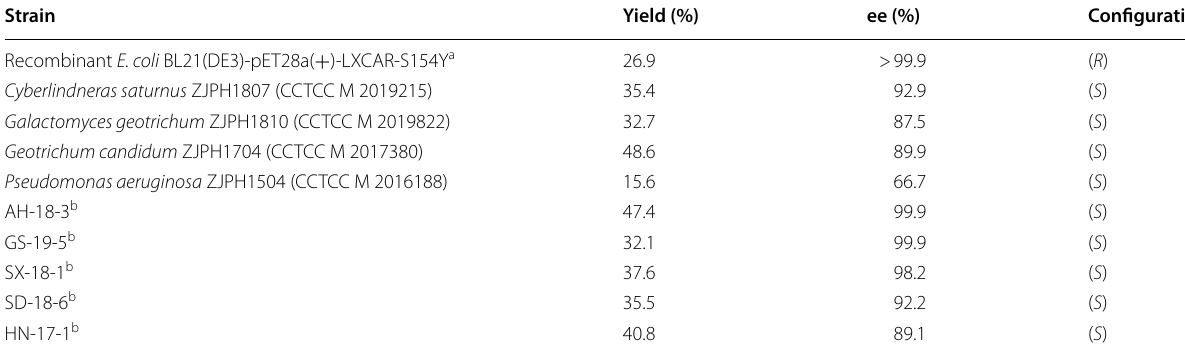
Table 1 Screening of biocatalysts Strain